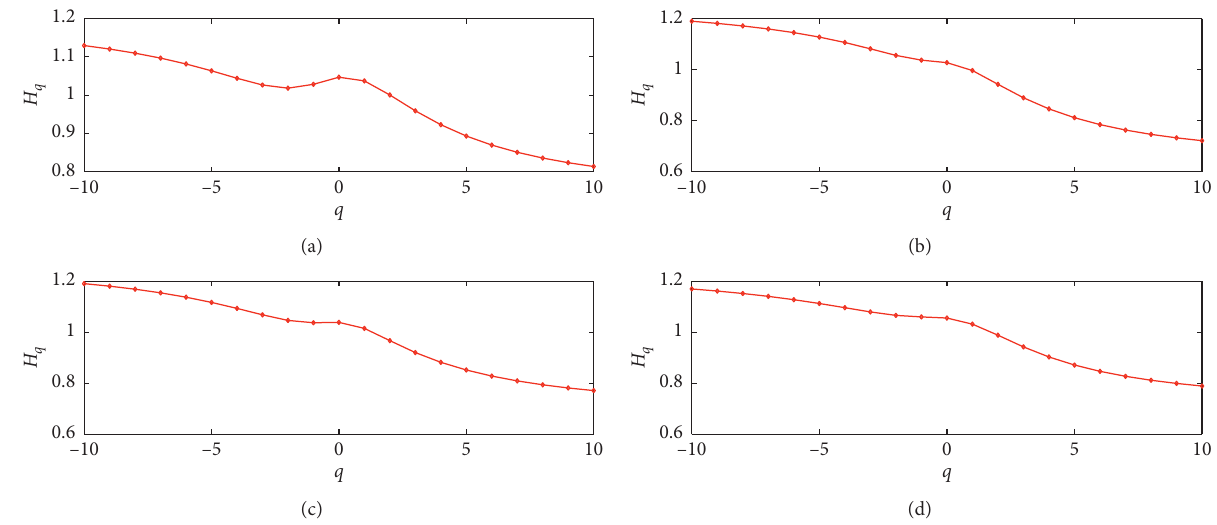
Figure 10: MF-DCCA scaling exponent for the market participation willingness and Chinese stock market returns volatility. (a) SME-YSI. (b) SSE50-YSI. (c) CSI300-YSI. (d) GEM-YSI.